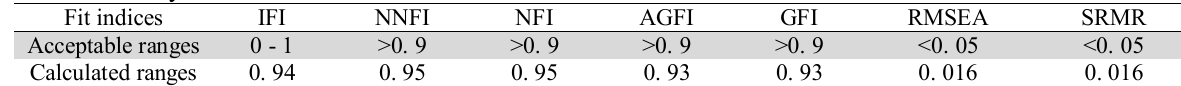
The summary of basic